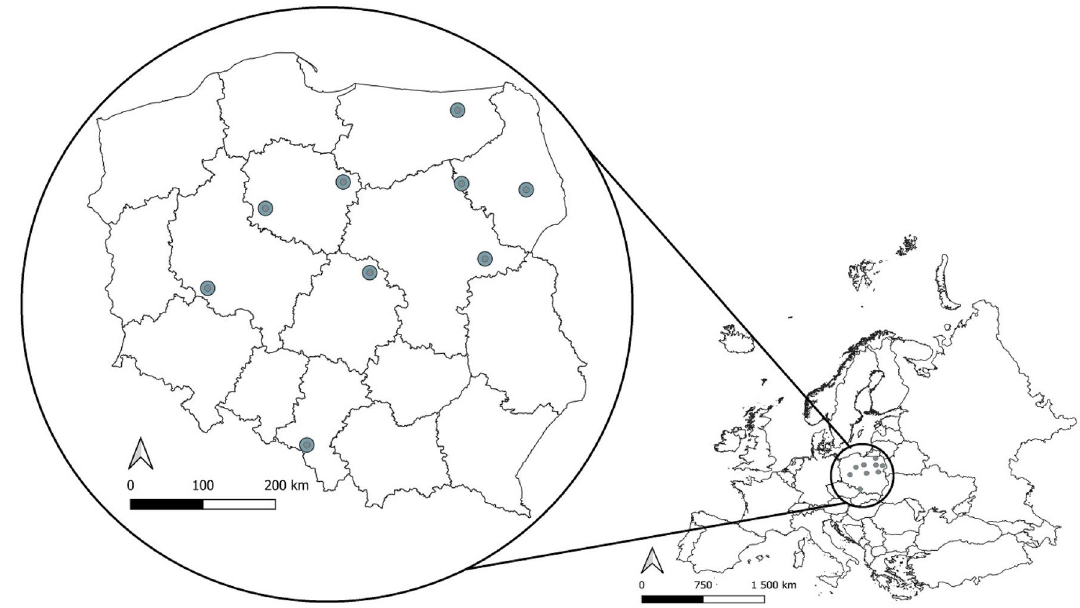
Figure 1. Map of Europe, with the location of studied landfills and censused areas around them (green dots). Data obtained from Eurostat (https:// ec. europa. eu/ euros tat/ web/ gisco/ geoda ta/ refer ence- data/ admin istra tive- units- stati stical- units/ count ries) and Head Office of Geodesy and Cartography (http:// www. gugik. gov. pl/ pzgik/ dane- bez- oplat/ dane-z- panst wowego- rejes tru- granic- i- powie rzchni- jedno stek- podzi alow- teryt orial nych- kraju- prg) under condition of non-commercial use. Figure generated with QGIS 3.18.0 (https:// qgis. org/ en/ site/ index.